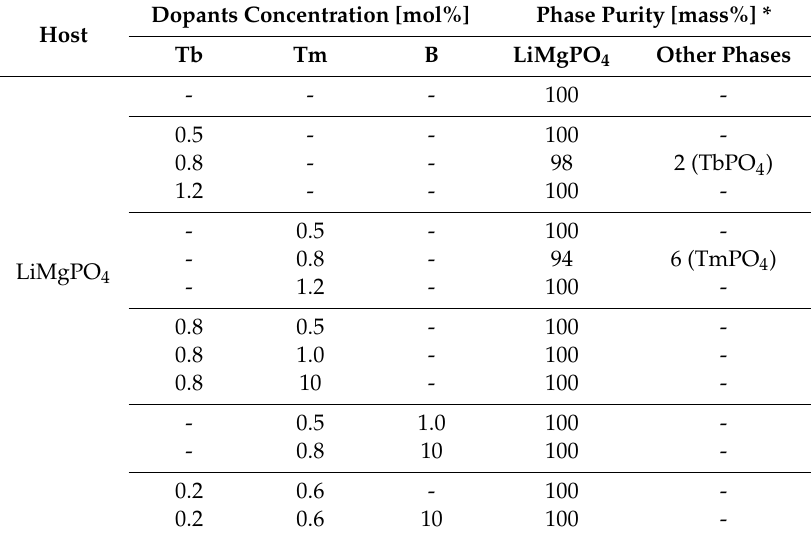
Table 1. Chemical composition of the samples studied in this